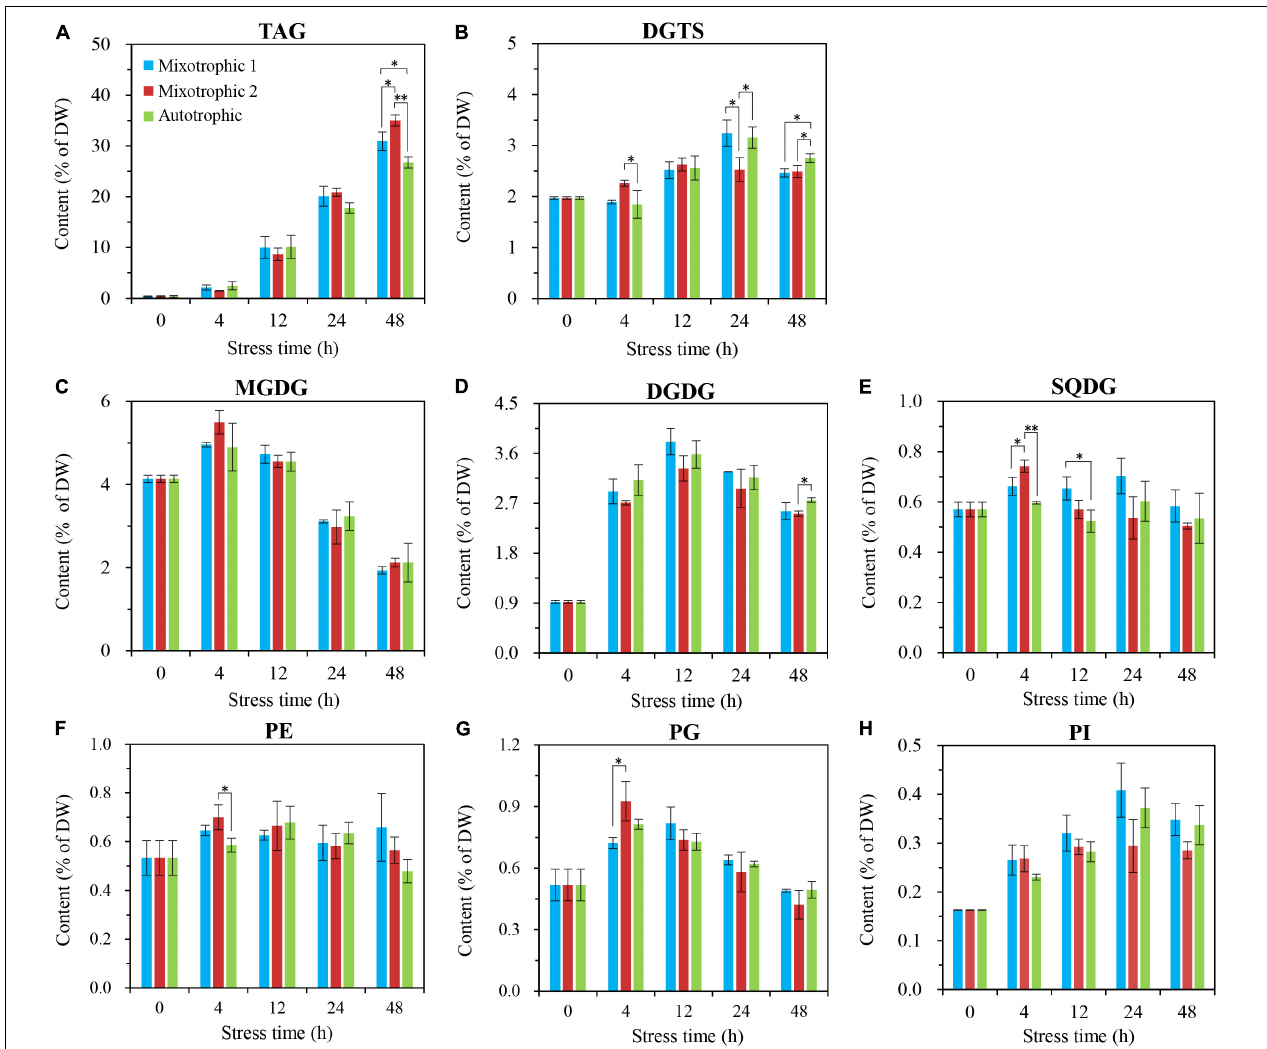
FIGURE 5 | Time course of changes in amounts of the individual glycerolipid class in C. reinhardtii BAFJ5 under three carbon supply regimes over 48 h of HL-N. The carbon supply regimes for mixotrophic 1, mixotrophic 2, and autotrophic were 17 mM acetate and 2% CO 2 (v/v), 17 mM acetate and ambient 0.04% CO 2 (v/v), and 2% CO 2 (v/v), respectively. Values are the means of three independent replicates ± SD ( n = 3). DW, cellular dry weight; ∗ p < 0.05; ∗∗ p <